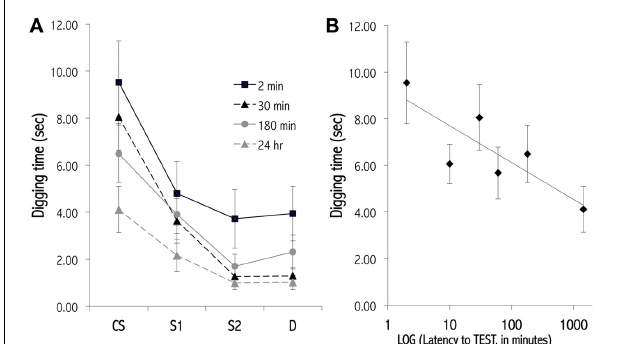
FIGURE 4 | Olfactory generalization gradients measured at various latencies after conditioning. (A) Progressive decay of a newly learned olfactory generalization gradient over an STM timescale. Mice received 12 massed training trials in which they dug in a dish of sand scented with a 1.0 Pa conditioned odor to retrieve a food reward. Separate cohorts of conditioned mice then were tested at different latencies for their perseverative responses (digging times) to the odor CS, a highly similar odorant S1, a moderately similar odorant S2, and a structurally and perceptually different odorant D. Responses declined and generalization gradients flattened with greater training-testing latencies. Methodology follows that of Cleland et al. (2009). Four of six latencies tested are depicted for clarity. (B) Lin-log plot of digging time in the CS during testing at all six latencies tested (2, 10, 30, 60, 180, 1440min). Data are fit with the regression line y = − 0 . 687ln(x) + 9.278, R 2 = 0 .